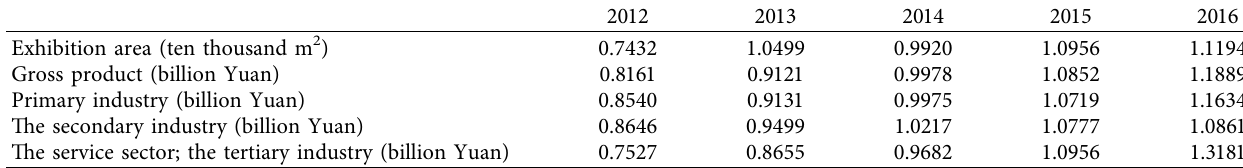
Table 3: The result of dimensionless processing of raw